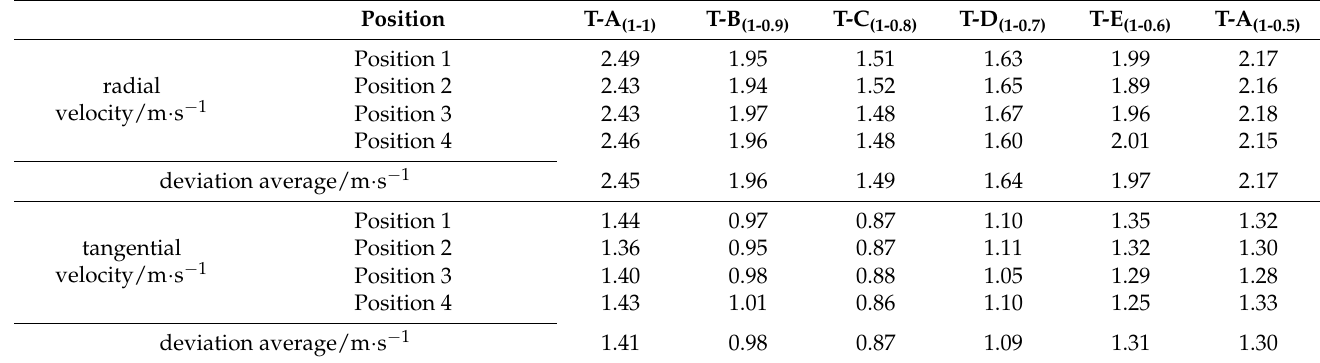
Table 4. Standard deviation comparison of velocity for different rotor cage models.